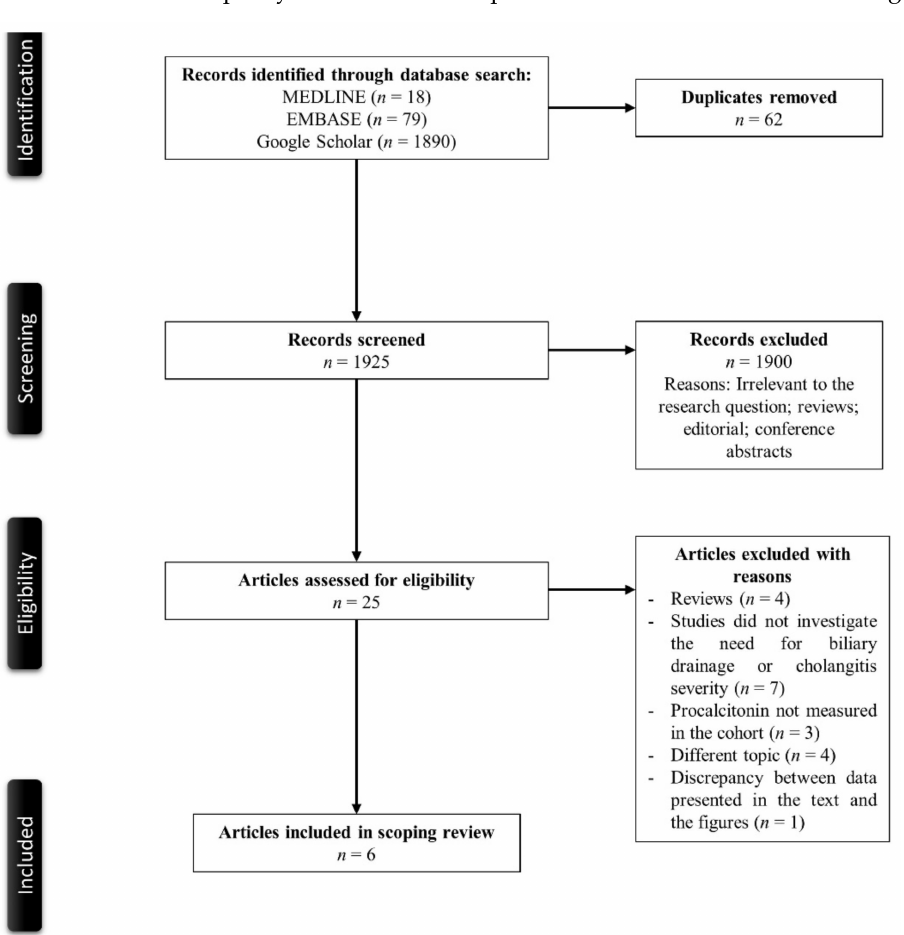
Figure 1. PRISMA (Preferred Reporting Items for Systematic Reviews and Meta-Analyses) flowchart of the search